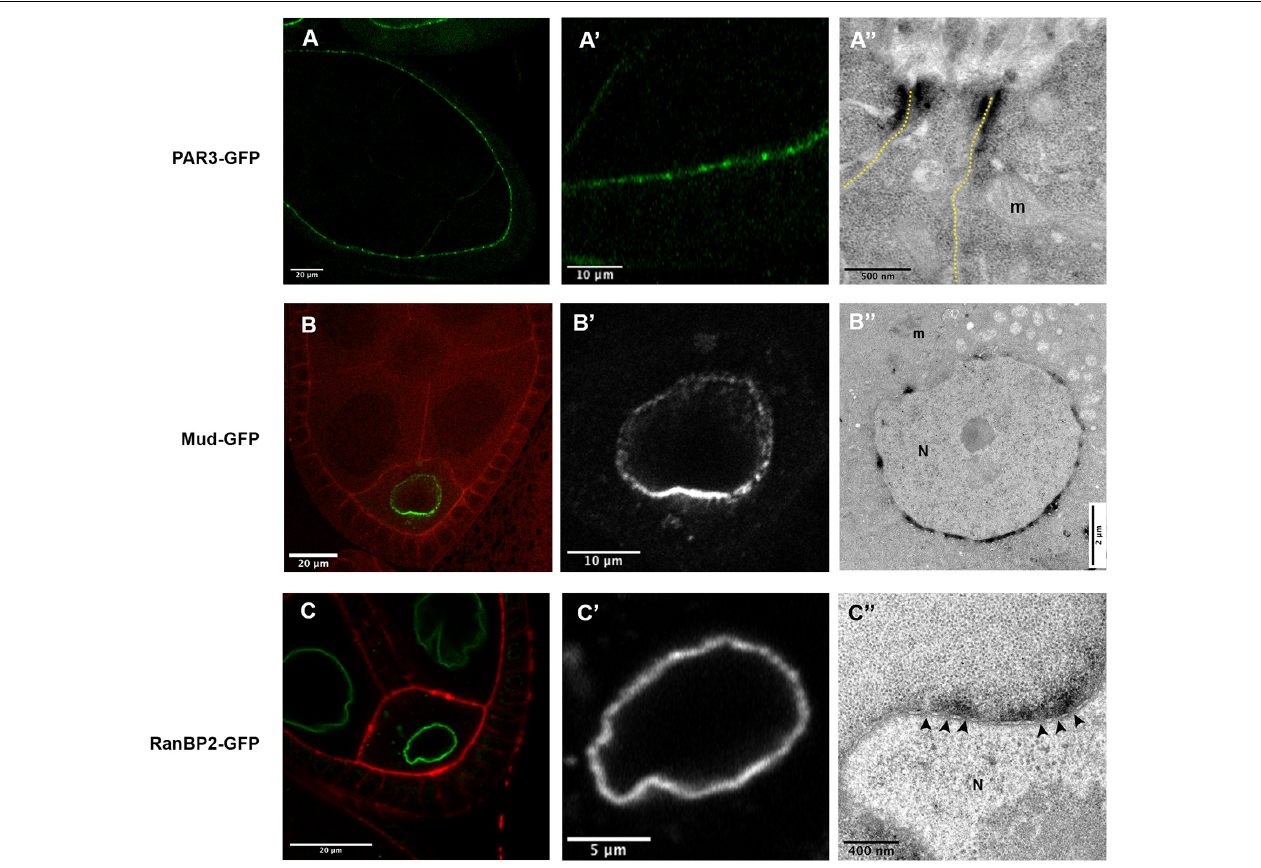
FIGURE 5 | (A) In P(Baz BAC . GFP ); Tj-GAL4 , UAS-APEX2-GBP egg chambers, Baz-GFP accumulate apically in the follicular cells, with a stronger accumulation at the junctional level (A,A’) . Consistently, a dense signal is revealed at the level of the junction between two follicular cells (A”) . (B) In mud 4 / mud 4 ; P(mud BAC . GFP ) / P(mud BAC . GFP ) ; nos-GAL4 VP 16 , UAS-APEX2-GBP follicles, an asymmetric distribution of Mud-GFP is observed at the nuclear envelope of the